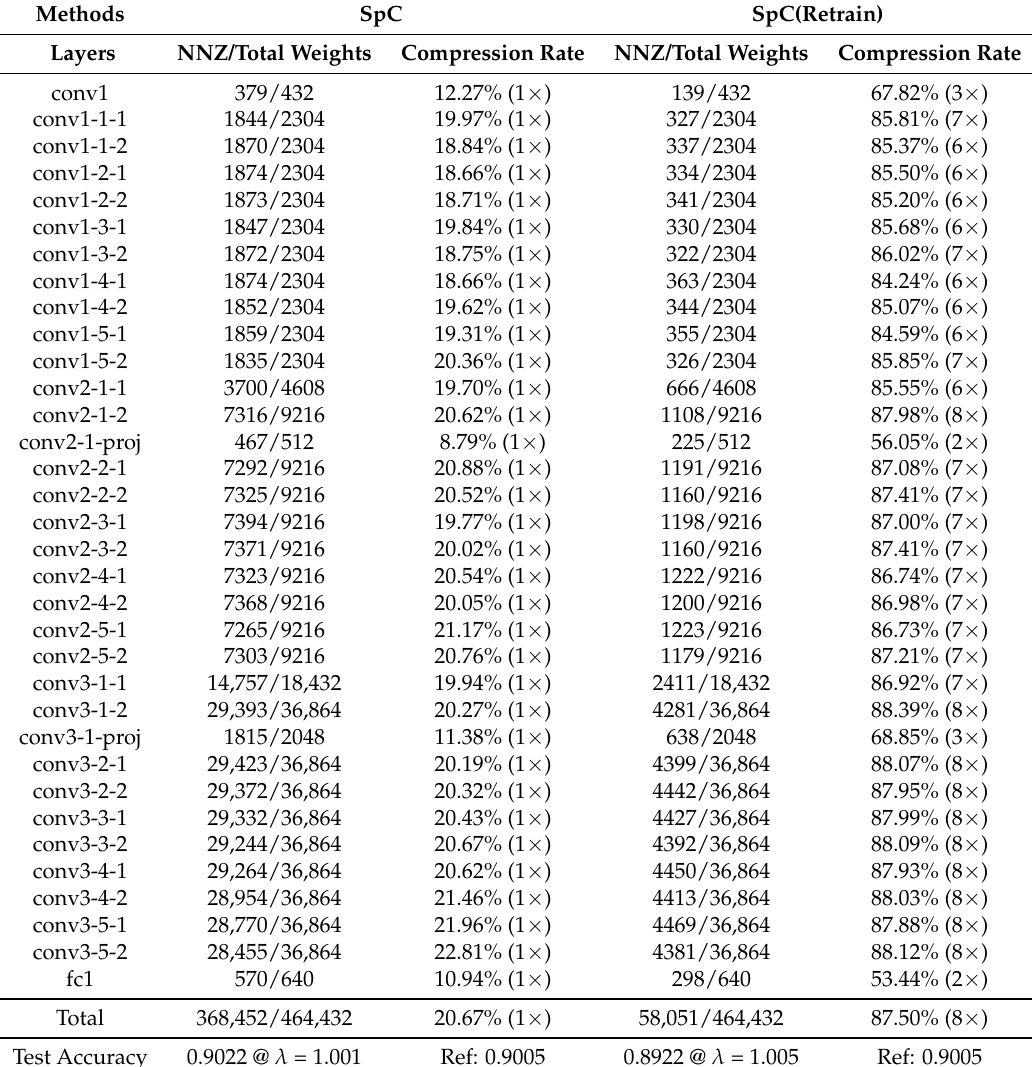
Table A4. Layer-wise compression of ResNet32 (CIFAR-10